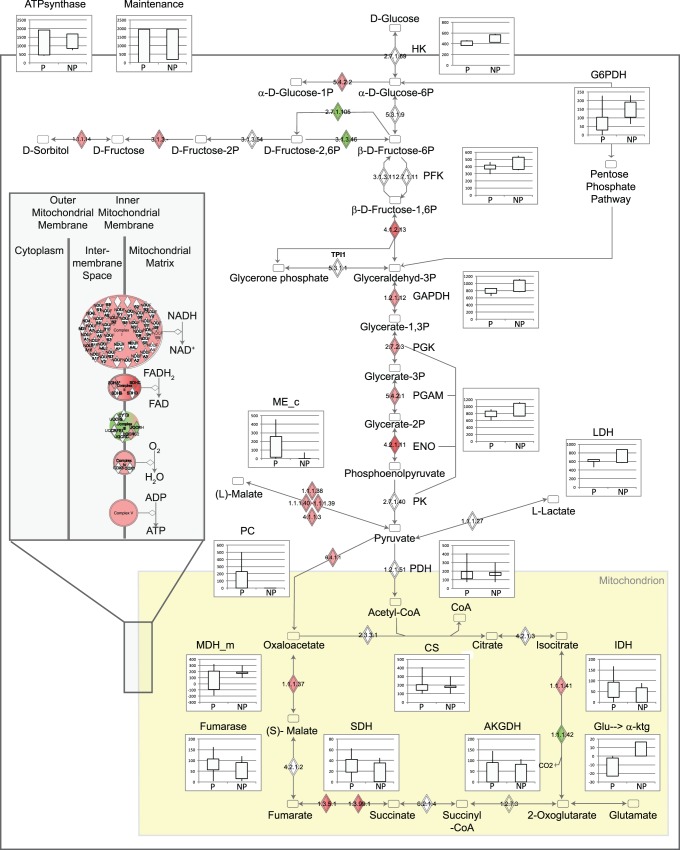
Overlay of fluxomics and transcriptomics results.Intracellular fluxes were calculated using a flux balance approach based on the maximization and minimization of ATP yield and are shown as solid bars with the 95% confidence interval, calculated from the adjusted rates plus/minus two times the estimated standard error, shown as vertical lines. Red/green coloured diamonds indicate which transcripts were down−/upregulated in producer cultures. Figure adapted from Ingenuity Pathway Analysis.